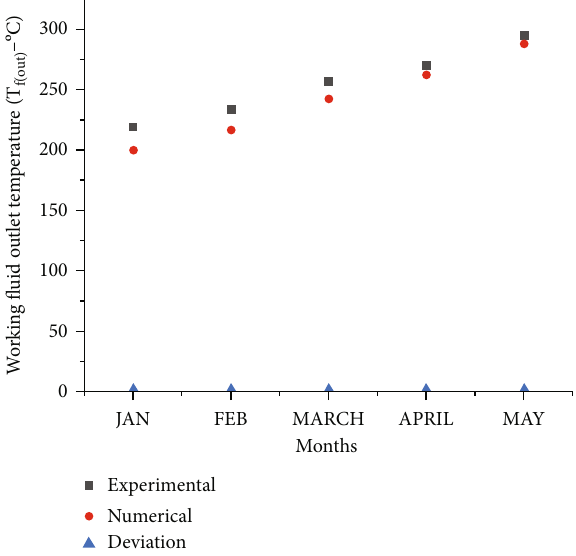
Figure 23: Deviation between experimental and numerical values of absorber temperature from January to May.